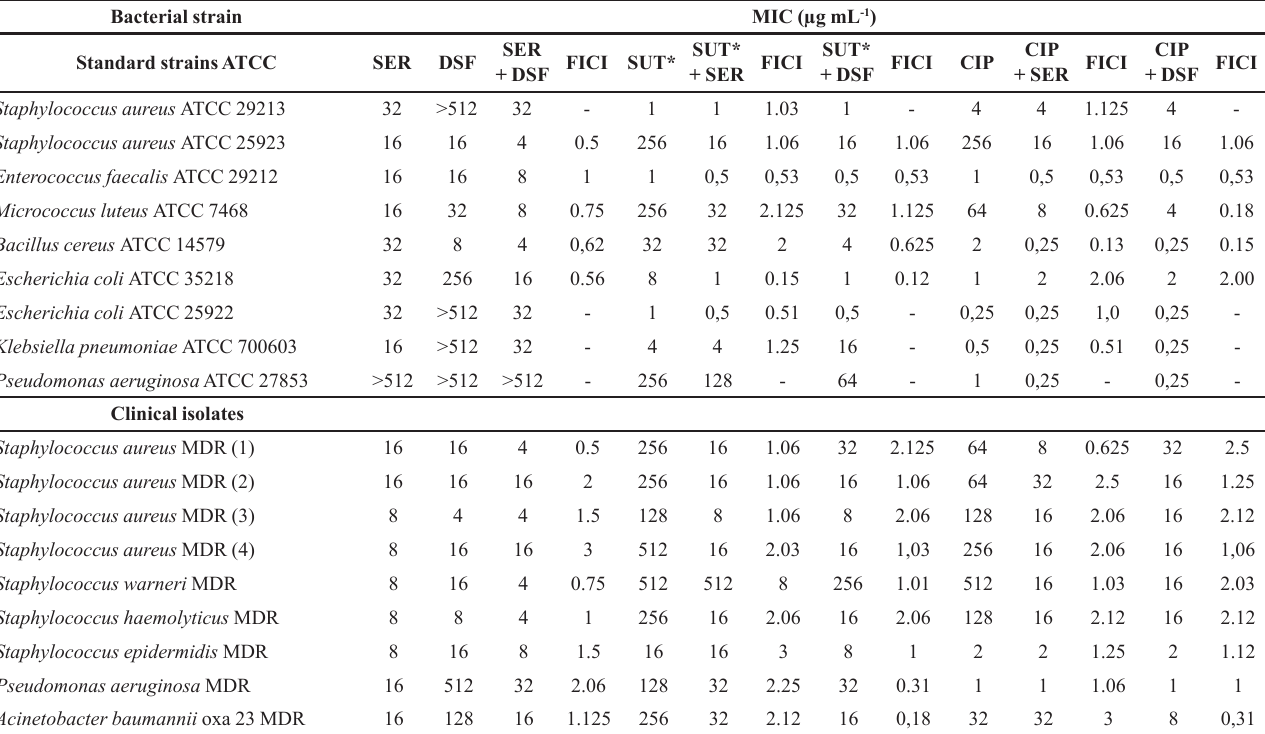
TABLE I – Minimum inhibitory concentrations (MIC) of the sertraline, disulfiram, sulfamethoxazole/trimethoprim and ciprofloxacin, alone and in combination against standard strains and clinical isolates Bacterial strain MIC (µg mL -1 ) Standard strains